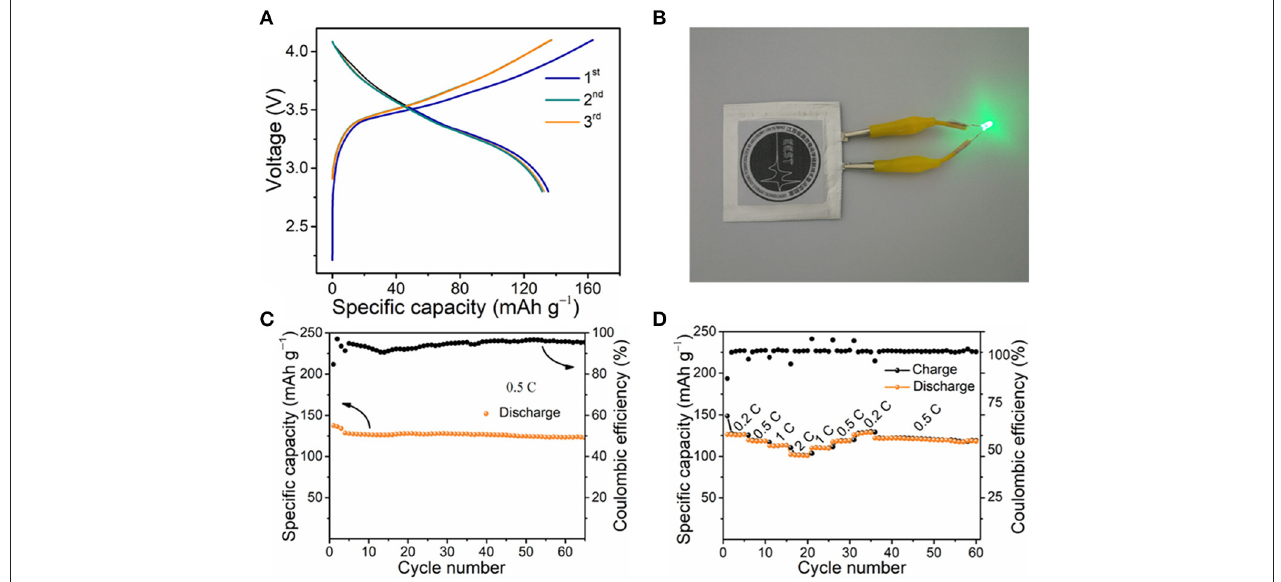
FIGURE 6 | Electrochemical performances of full-cell. (A) Charge–discharge profiles for a Si@rGONSs-2//Li[Ni 1 / 3 Co 1 / 3 Mn 1 / 3 ]O 2 (NCM 111) full cell between 2.8 and 4.1V at 0.5C, (B) the photograph of LED lamps lighted by Si@rGONSs-2//NCM 111 pouch cell, (C) cycling performance of Si@rGONSs-2//NCM 111 full cell at 0.5C, and (D) rate performance from 0.2 to